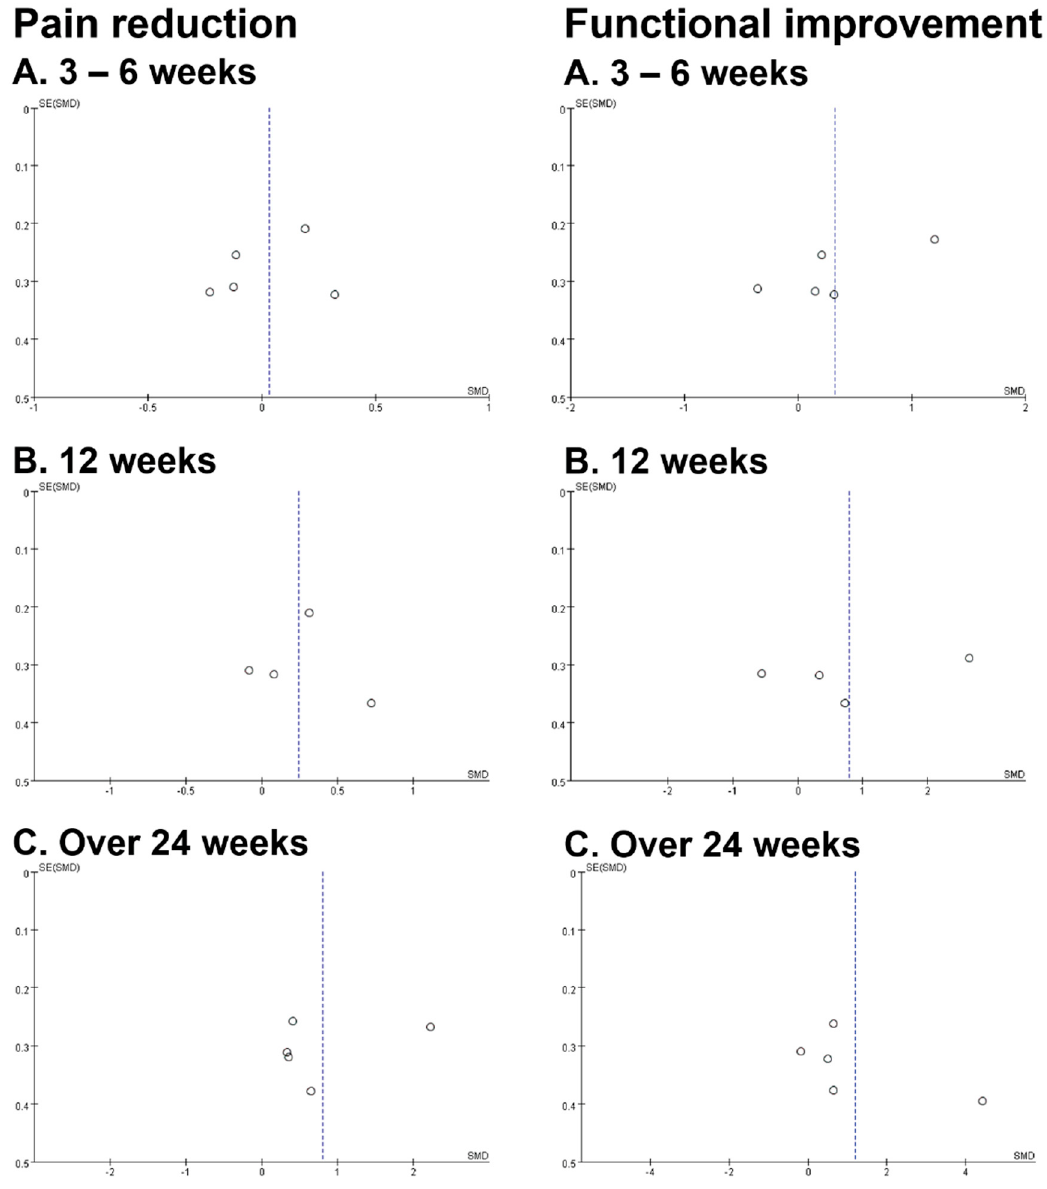
Figure 4. Funnel plots showing publication bias for pain reduction (left) and functional improvement (right) at the short term ( A , 3–6 weeks), the medium term ( B , 12 weeks), and the long term ( C , over 24 weeks).